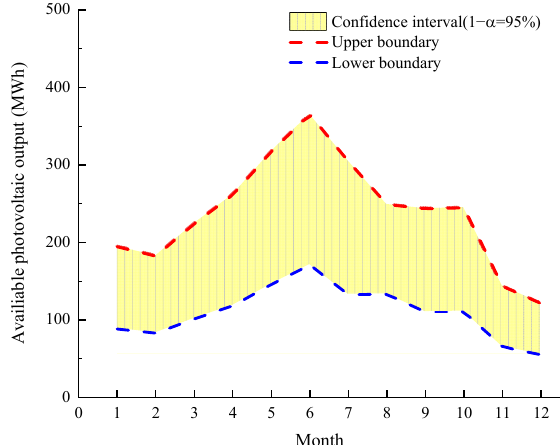
Figure 7. Monthly available photovoltaic-power output.